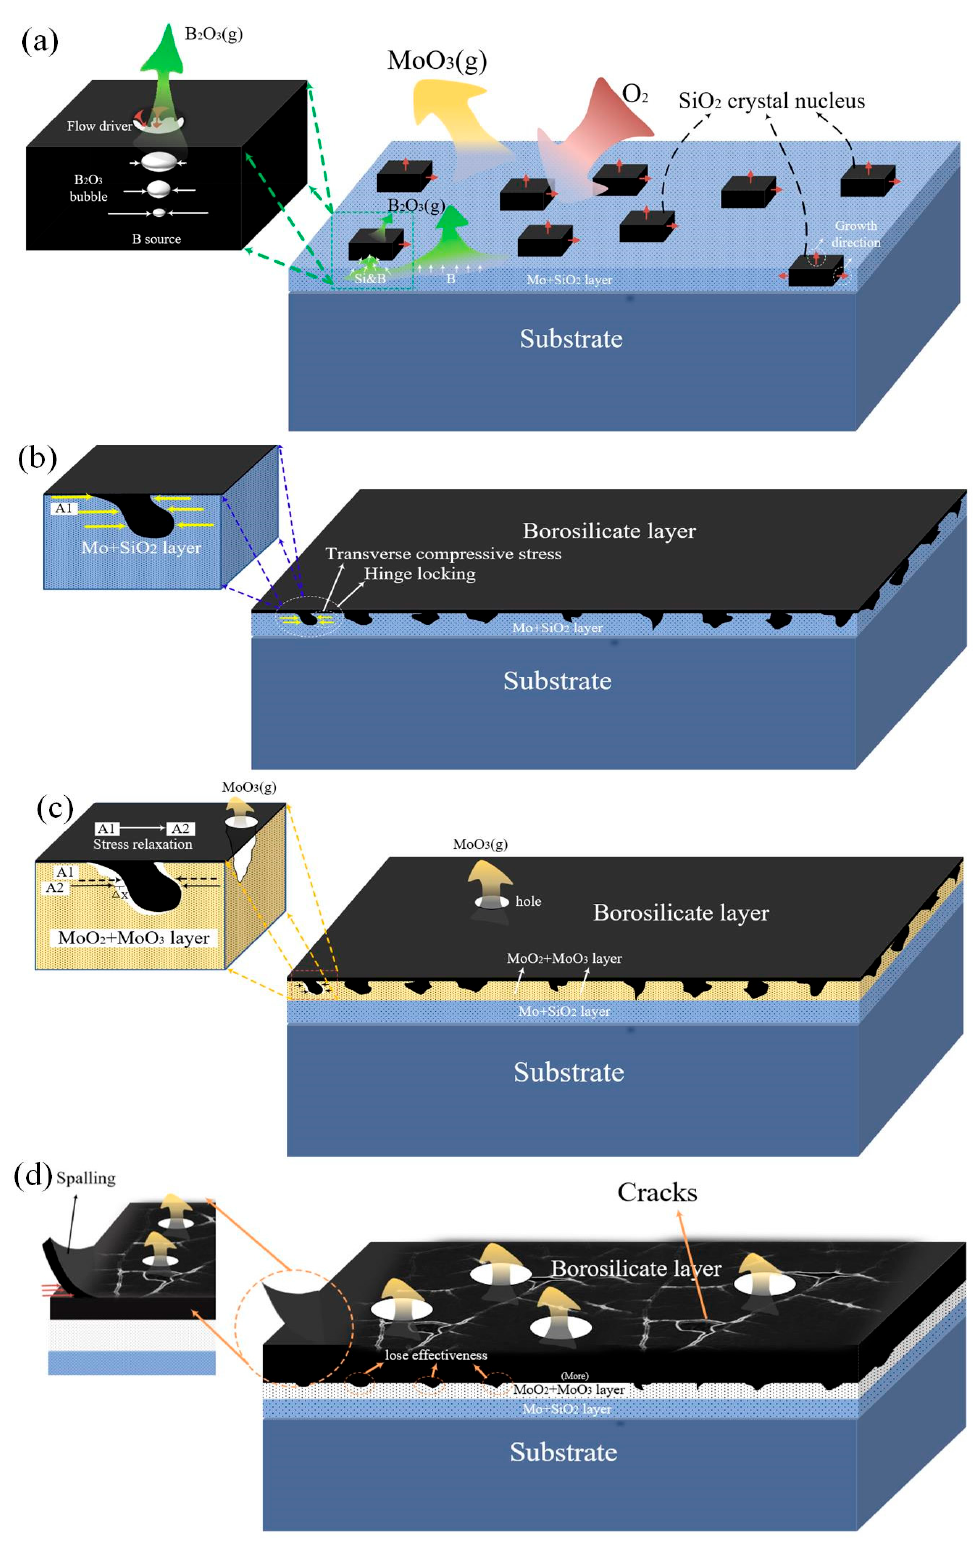
Figure 7. Pre-oxidation and cyclic oxidation mechanism diagram:( a , b ) are pre-oxidation progress at Figure 7. Pre ‐ oxidation and cyclic oxidation mechanism diagram:( a , b ) are pre ‐ oxidation progress at 1300 ◦ C; ( c , d ) are cyclic oxidation progress at 1150 ◦ 1300 °C; ( c , d ) are cyclic oxidation progress at 1150 °C.